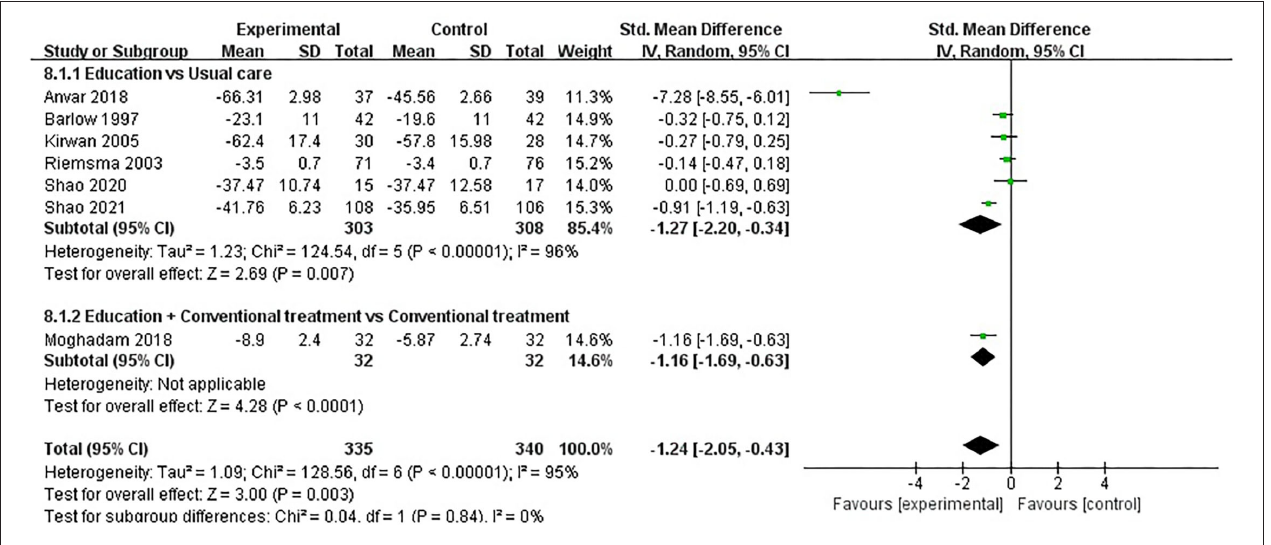
FIGURE 9 | Meta-analysis on ASE